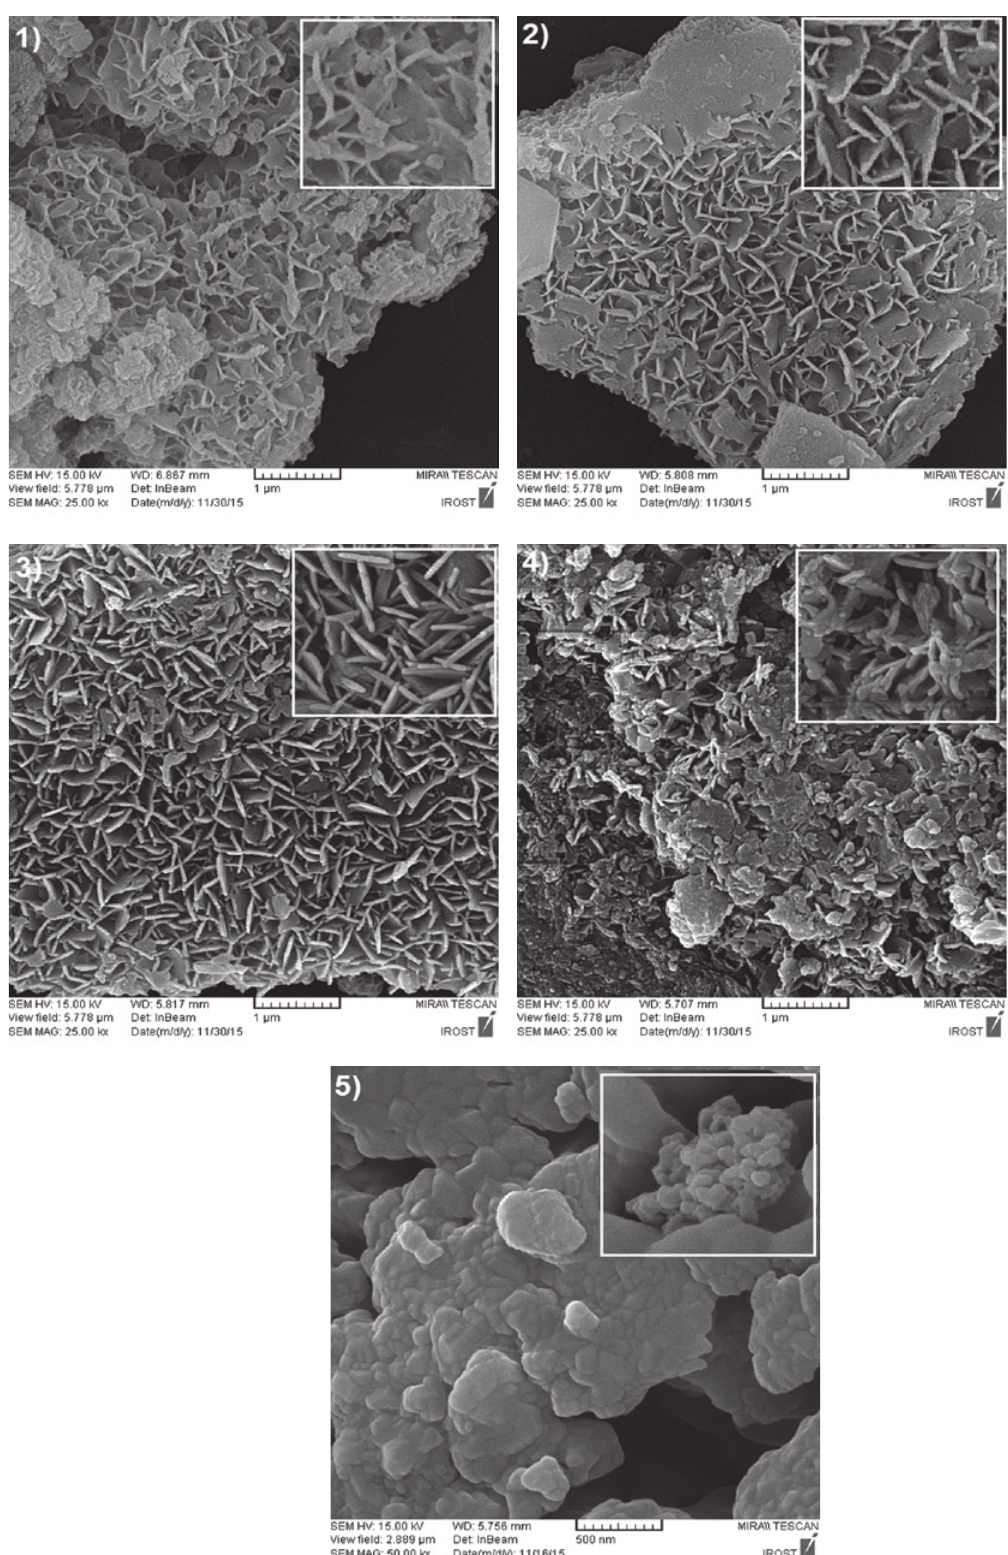
Figure 4: FE-SEM images for samples after immersion in SBF. (1) HA, (2) CA, (3) nanocomposite obtained by method 1, (4) nanocomposite obtained by method 2, and (5) nanocomposite obtained by method